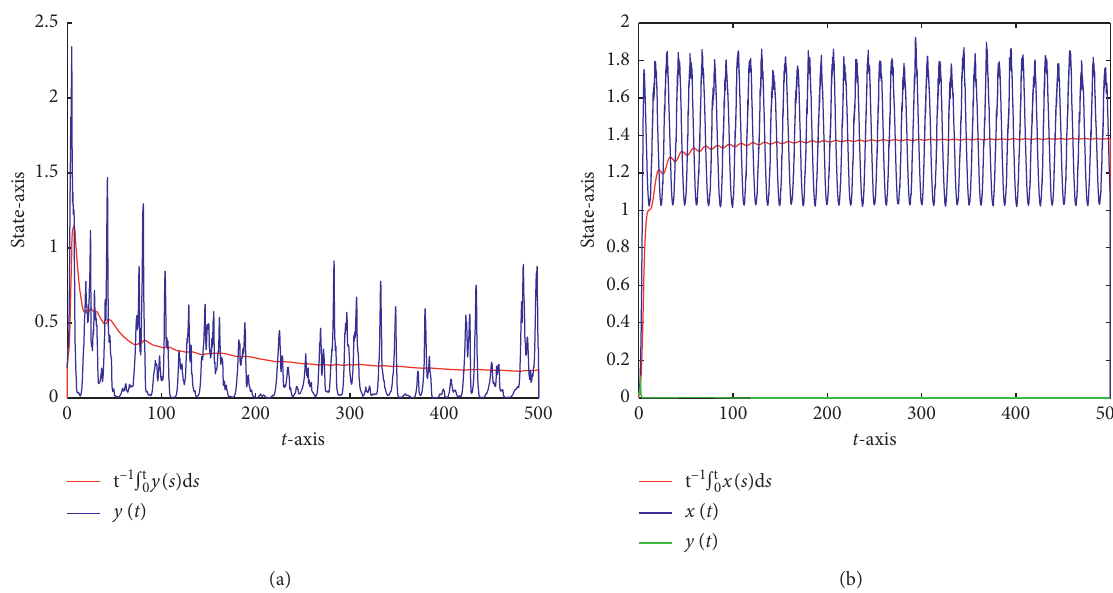
Figure 5: The dynamics of x and y of (5) with n � 1 and x ( 0 ) � y ( 0 ) � 0 . 02. (a) The permanence in the mean of y